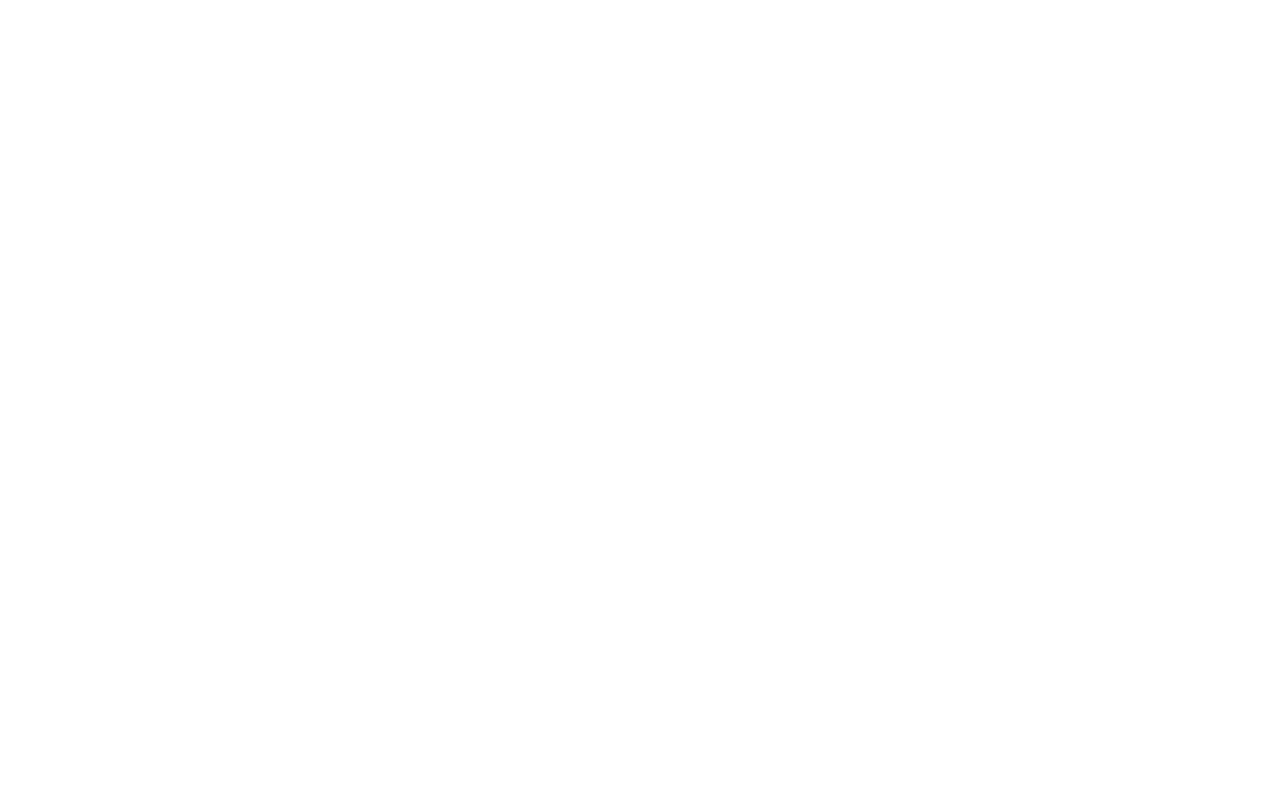
Frontiers in Neurology |